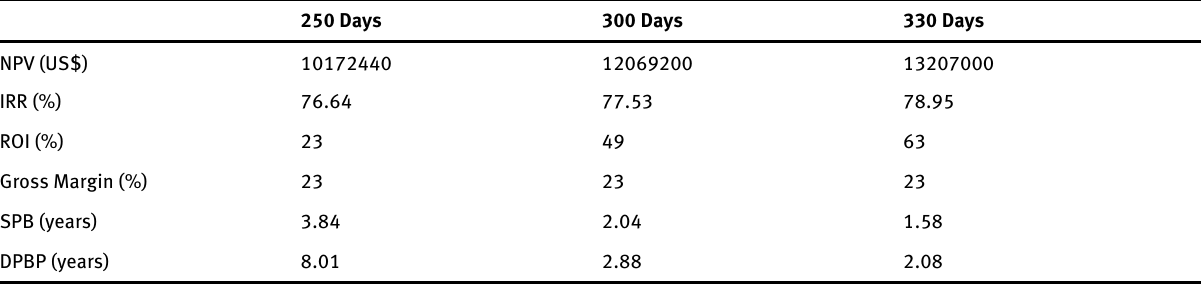
Table 5 : Profitability indicators of the cookies production plant 250